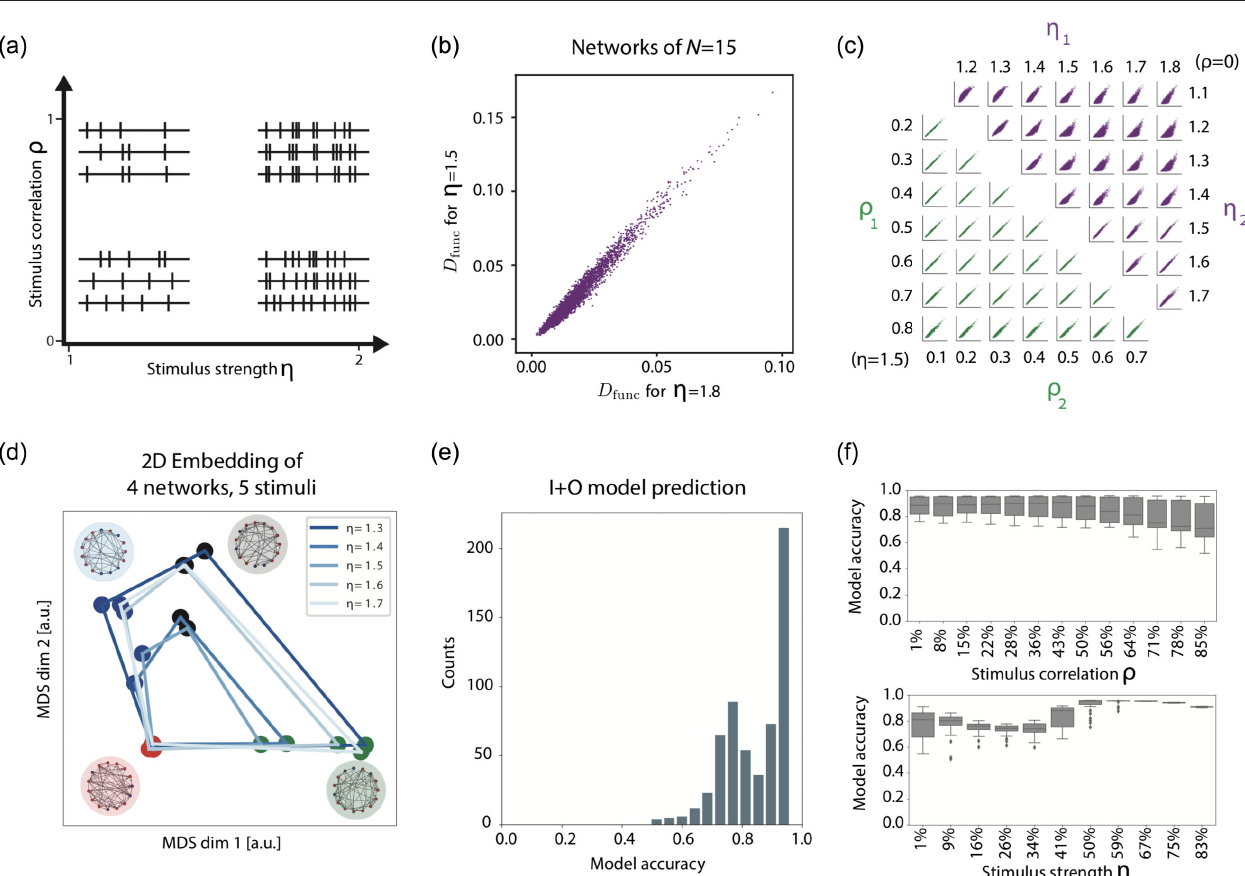
FIG. 5. The structure of the map of functional similarities between networks is conserved across stimuli. (a) Illustration of the space of different stimuli for which we compute the pairwise similarity between networks. The set of stimuli explored is characterized by the average rate of the external Poisson input to the neurons, η , and the correlation between different inputs to different neurons, ρ . (b) An example of the correspondence of D for 1 million pairs of networks in the ensemble of networks of size N ¼ 15 is shown for two func different stimuli; every dot represents one pair of networks. (c) The same as (b) but for many pairs of stimuli, from the parametric space of stimuli, described in (a). The correlations between the distances between all pairs of networks are shown for the whole range of ρ and η values. Green panels show the case of varying ρ , at fixed η ¼ 1 . 5 ; purple panels varying η at fixed ρ ¼ 0 . (d) Five overlaid 2D MDS embeddings of four example networks of size N ¼ 15 , based on the functional dissimilarity between them. The networks in each case are the same and are marked by a dot of the same color. The colors of the lines between nodes denotes which of the five stimuli this embedding relates to. Overlaying is done by anchoring the network marked by the red dot. Overlaid maps show the geometric organization is preserved across stimuli space. (e) Pearson correlation between the computed functional similarity D between func networks and predictions of the models based on the sum of synaptic inputs and sum of synaptic outputs of each neuron, for 900 different combinations of ð η ; ρ Þ for networks of size N ¼ 15 . (f) The interquartile ranges of the data shown in (e) are shown by aggregating the values shown in (e) over η (top) and ρ (bottom). Percentage values of each bar denote the parameter value between lowest strength or correlation (0%) and highest ones